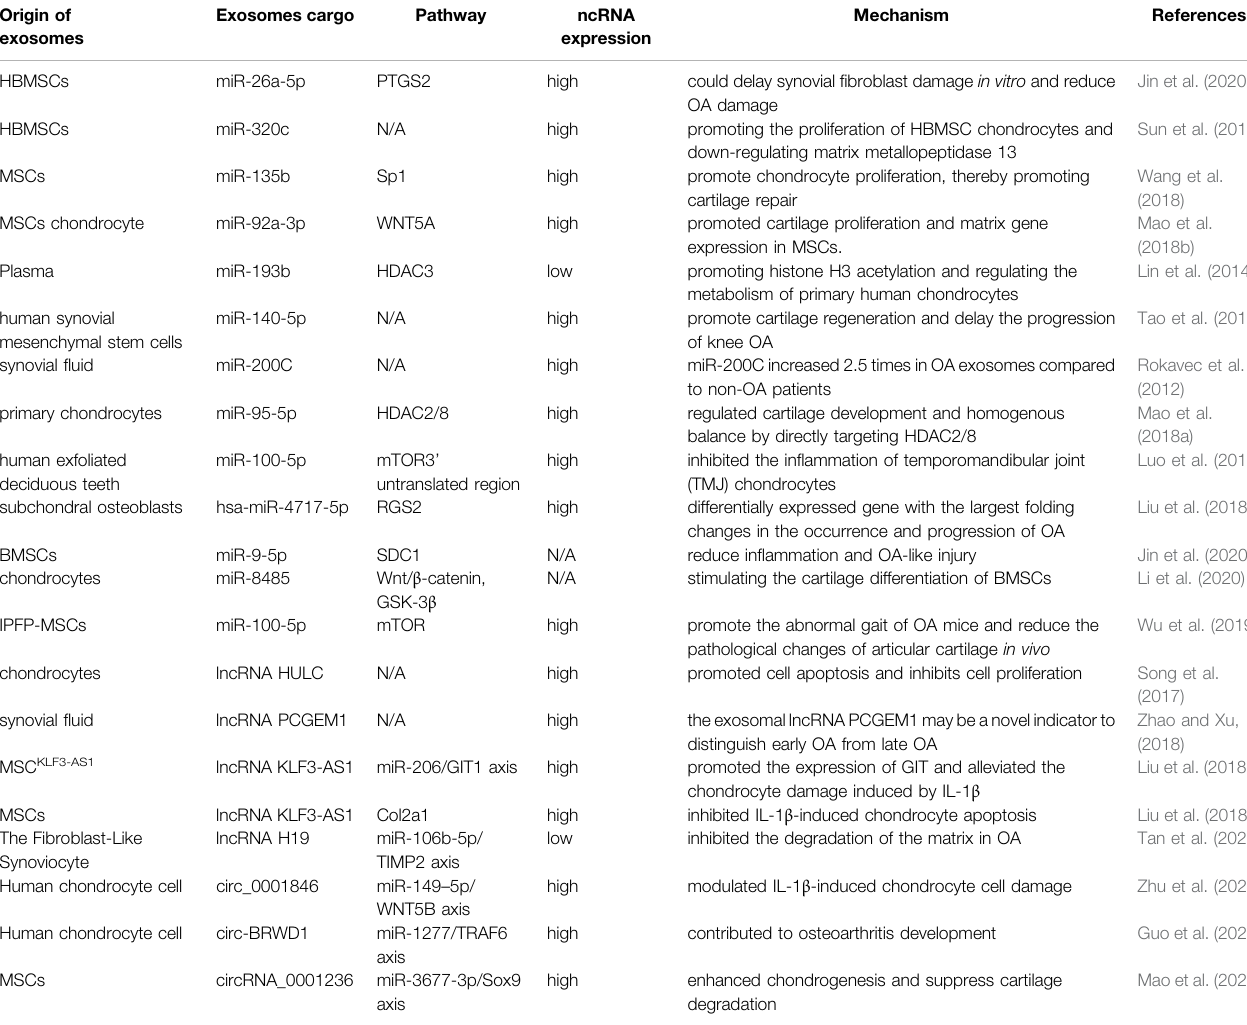
TABLE 2 | The role of exosomal non-coding RNAs in osteoarthritis. Origin of